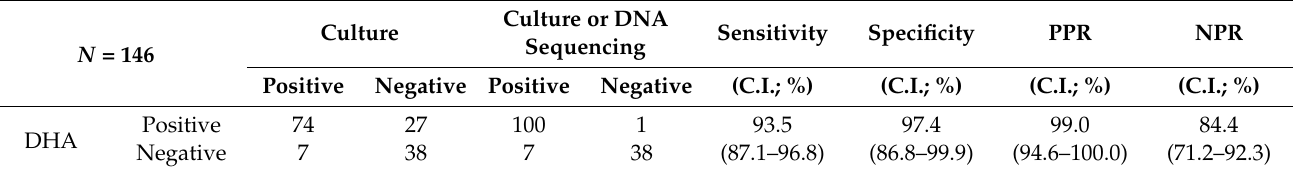
Table 4. The performance of the dot hybridization array for diagnosing fungal